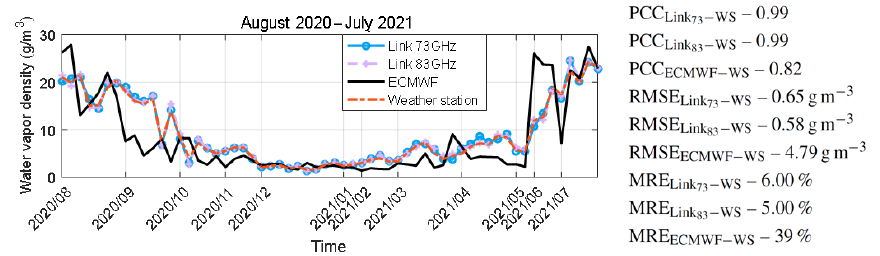
Figure 6. The water vapor density graphs from the link, the ECMWF reanalysis, and the weather station measurement. These include the correlation, root mean square error, and the mean relative error between the link and the weather station measurement, the ECMWF, and the weather station measurement, respectively. Note: WS – weather